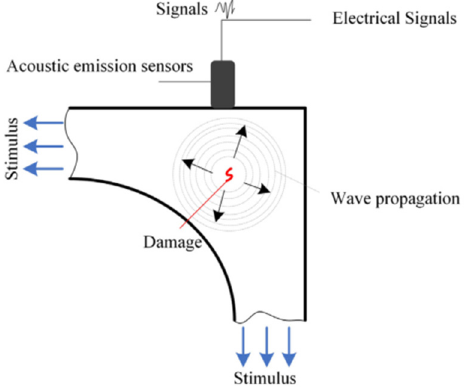
Figure 8. Principle of acoustic emission detection technology [53].